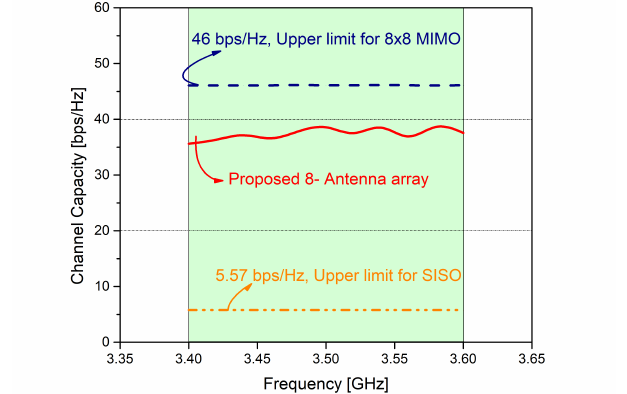
Figure 9. Channel capacity of the proposed MIMO antenna